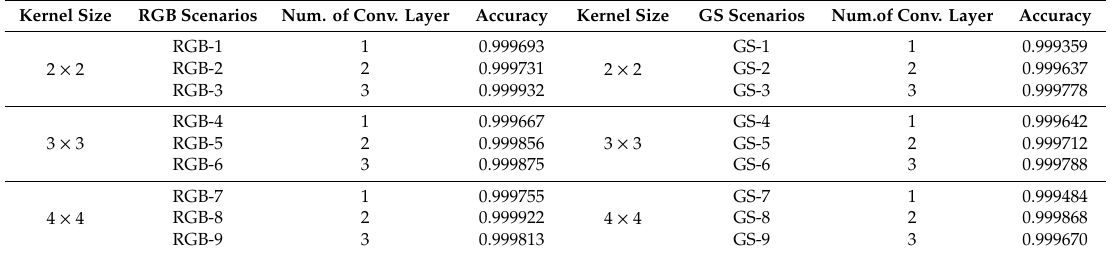
Table 6. Accuracy by Number of Convolution Layers in binary classification for KDD. Kernel Size